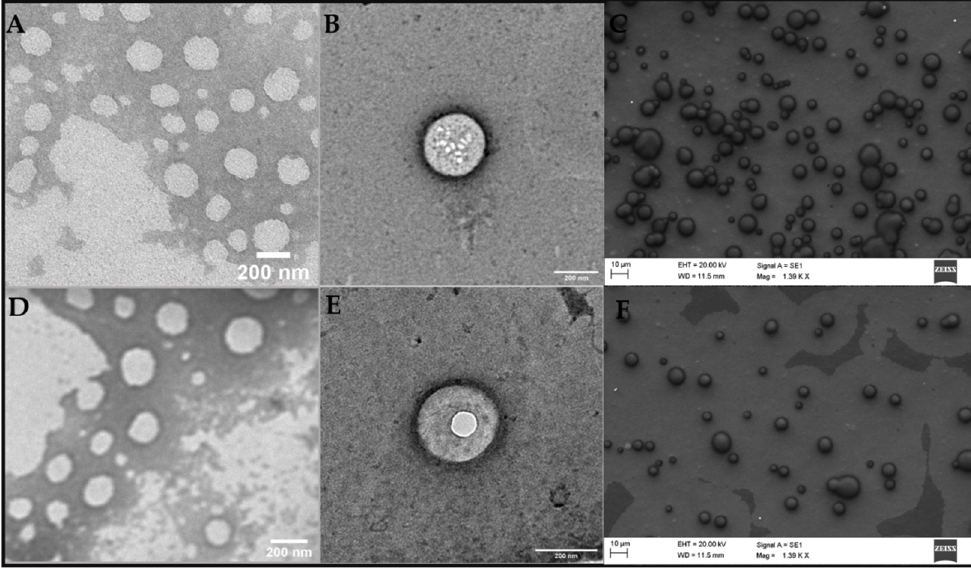
Figure 3 . TEM ( A , B , D , E ) and FE ‐ SEM ( C , F ) micrographs of the optimized formulation: NLC DTX ( A – C ) its control, and NLC CTL ( D – F ). Magnitudes: 30,000× ( A , D ), 49,000× ( B , E ) and 1390× ( C , F